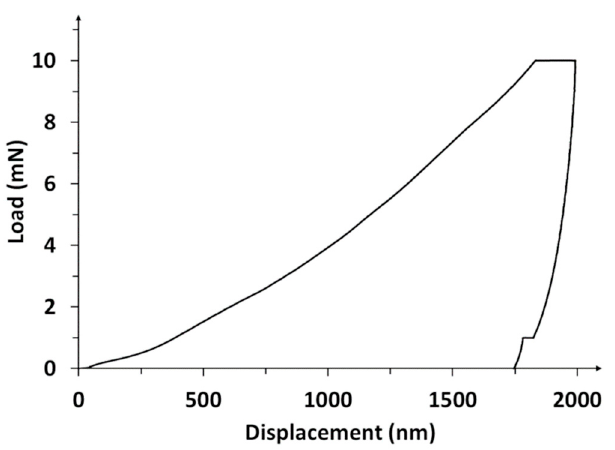
Figure 5. Nanoindentation load–displacement curve obtained for the MWCNTs/TiO 2 coating.